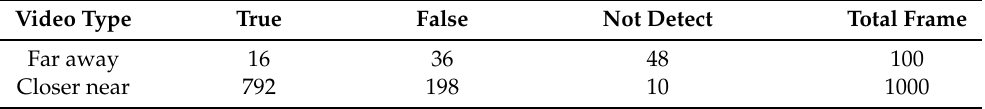
Table 6. Recognition rate experiment according to the distance between the camera and the child. Video